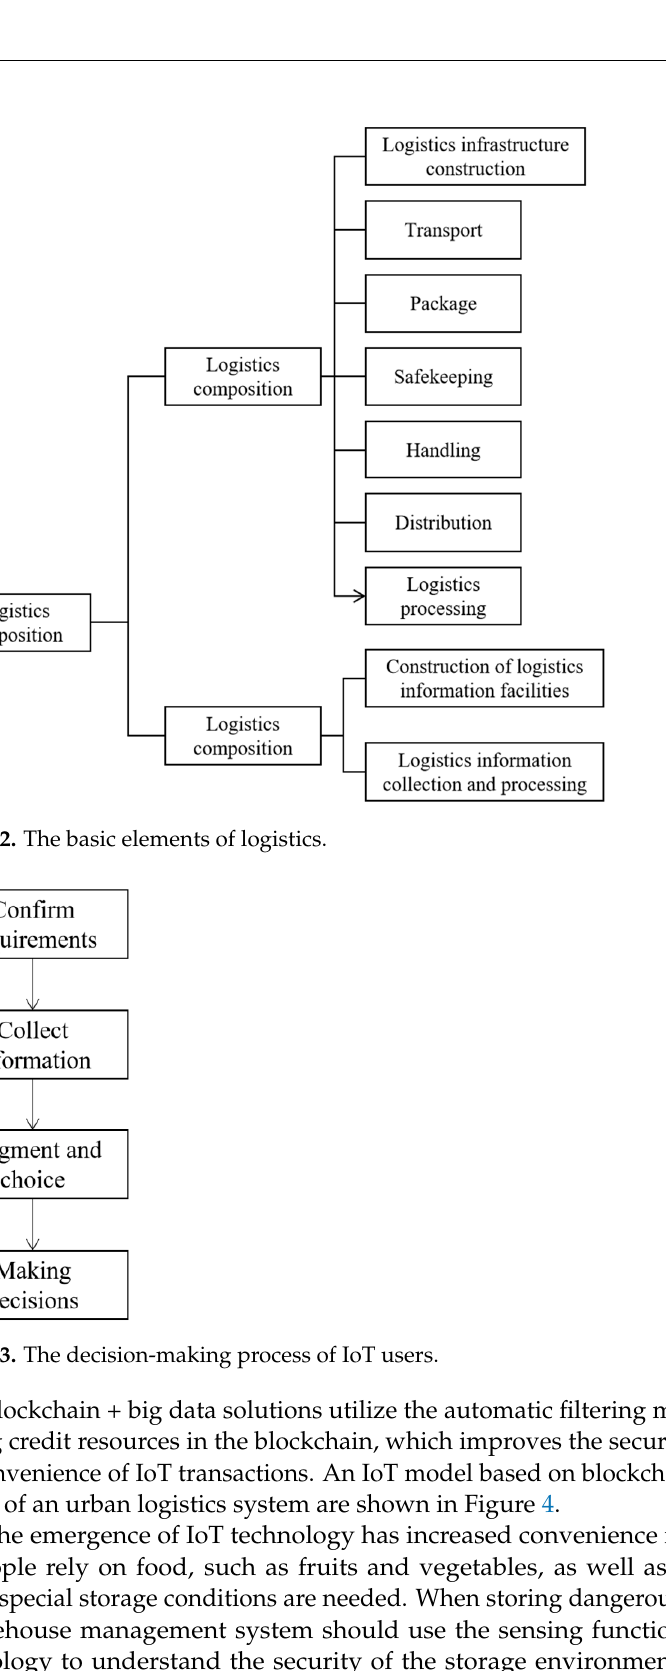
Figure 4. Blockchain-based IoT model and conceptual model of an urban logistics system.